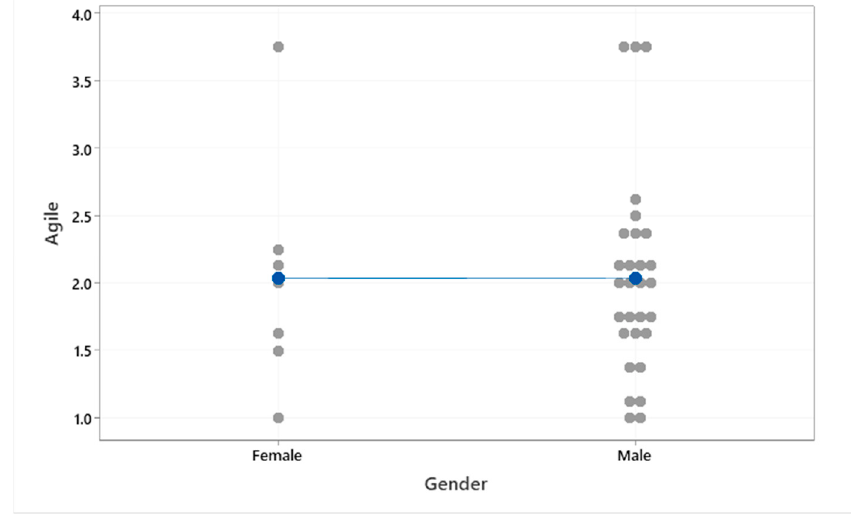
Figure 15. Individual value plot of agile vs. gender.